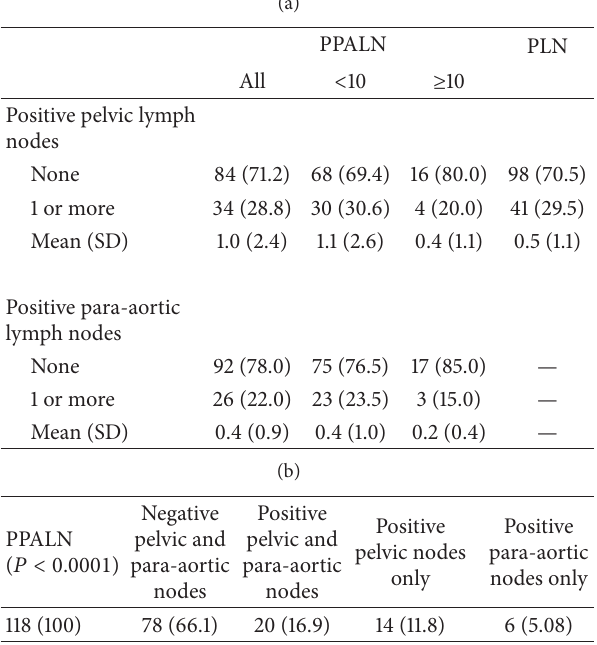
Table 3: (a) Number of positive lymph nodes in the PLN and PPALN groups. (b) Breakdown of pelvic and para-aortic nodal metastasis in the PPALN